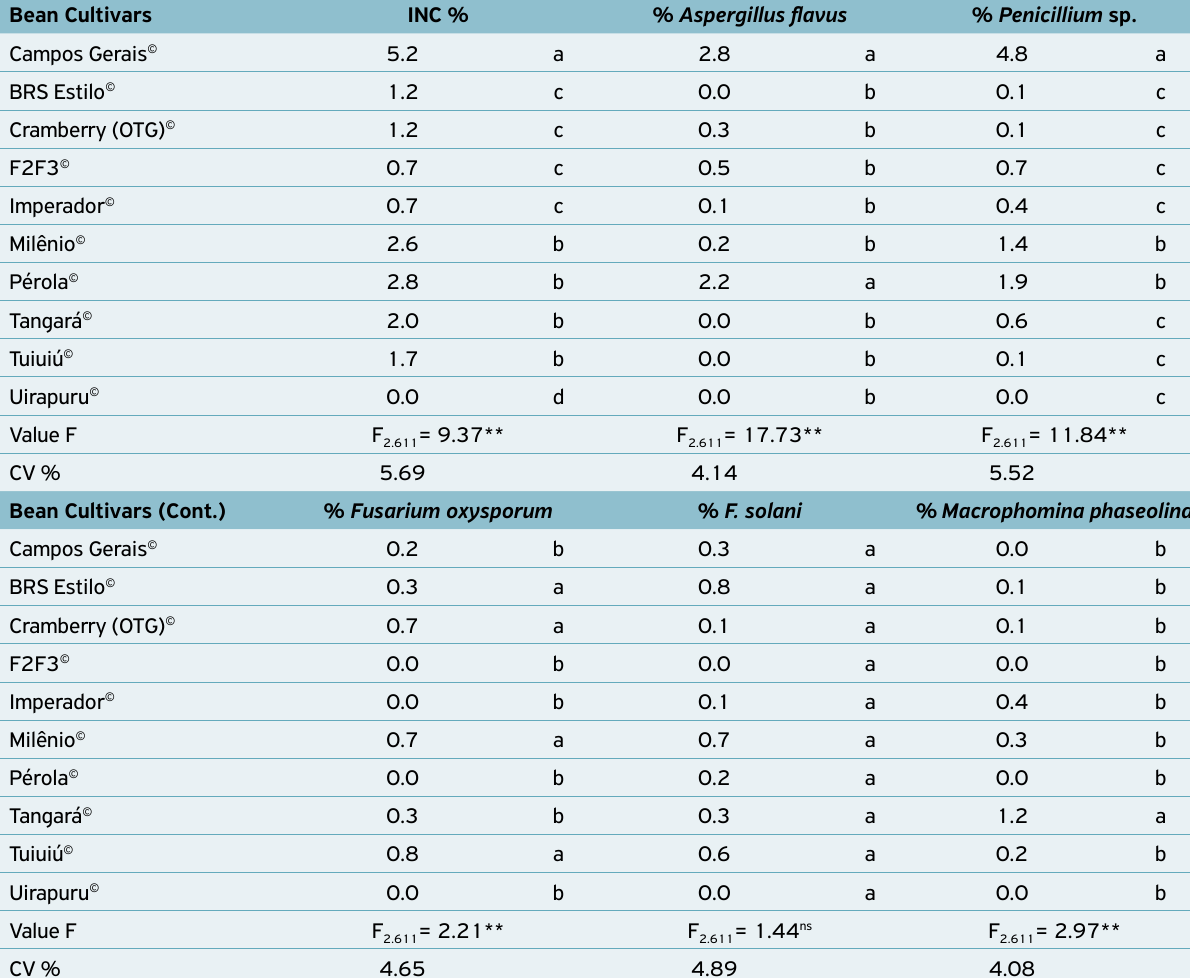
Table 4. Transforms Averages √(X+10) by microorganism incidence (INC %) and incidence by Aspergillus flavus, Penicillium sp., Fusarium oxysporum, Fusarium solani and Macrophomina phaseolina on beans cultivars*. Bean Cultivars INC % % Aspergillus flavus % Penicillium